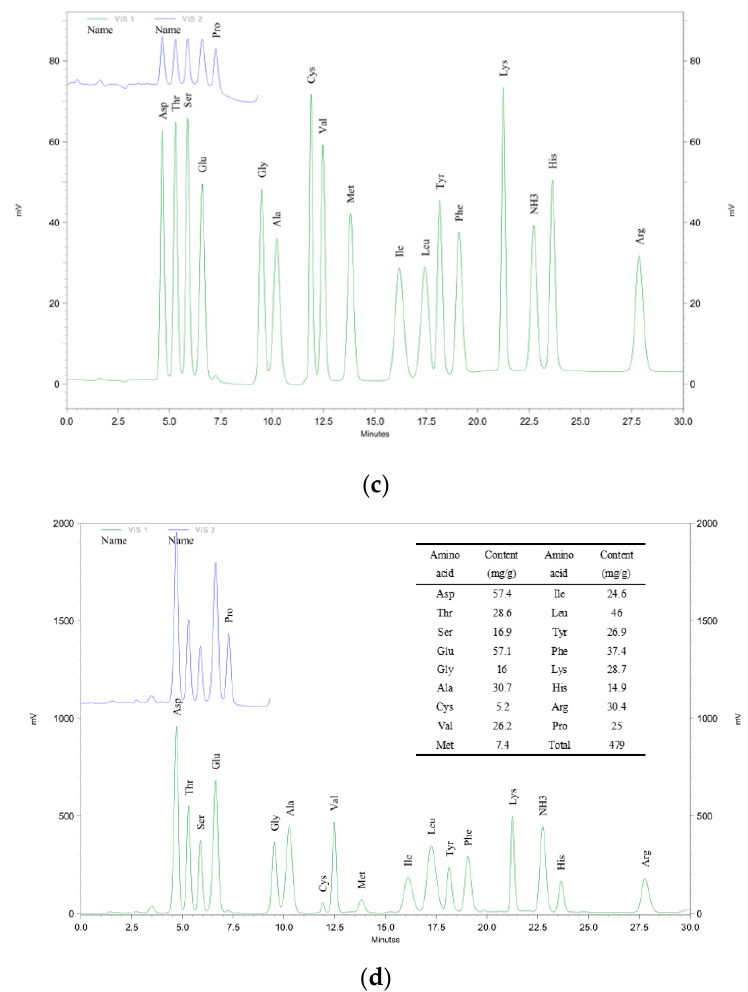
Figure 4. Composition of monosaccharides and amino acids in the IRS (( a ): monosaccharide content, ( b ): monosaccharide composition in the IRS, ( c ): amino acid content, ( d ): amino acid composition in